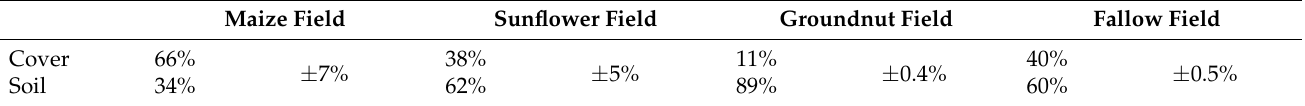
Table 4. The cover and soil percentages of each field as identified by the UAV